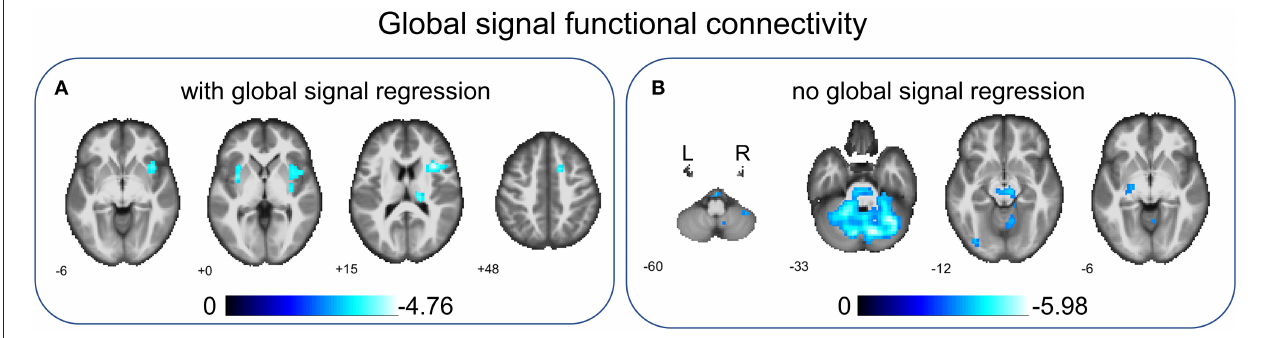
FIGURE 4 | Between-group comparisons of global signal FC with/without global signal regression. After global signal regression, significantly decreased global signal FC was found in the right insular gyrus (INS.R), right thalamus (Thalamus_R), right superior frontal gyrus (SFG.R), and right putamen (Putamen_R) in children with BECTS compared with HCs (A) . Before global signal regression, significantly decreased global signal FC was revealed in the inferior occipital gyrus (IOG.L) and part of the bilateral cerebellum (left and right lobule Crus1) in children with BECTS when comparing to HCs (B) . These results were voxel-wise p < 0.001, cluster level p < 0.05, family-wise error (FWE) cluster-level corrected.